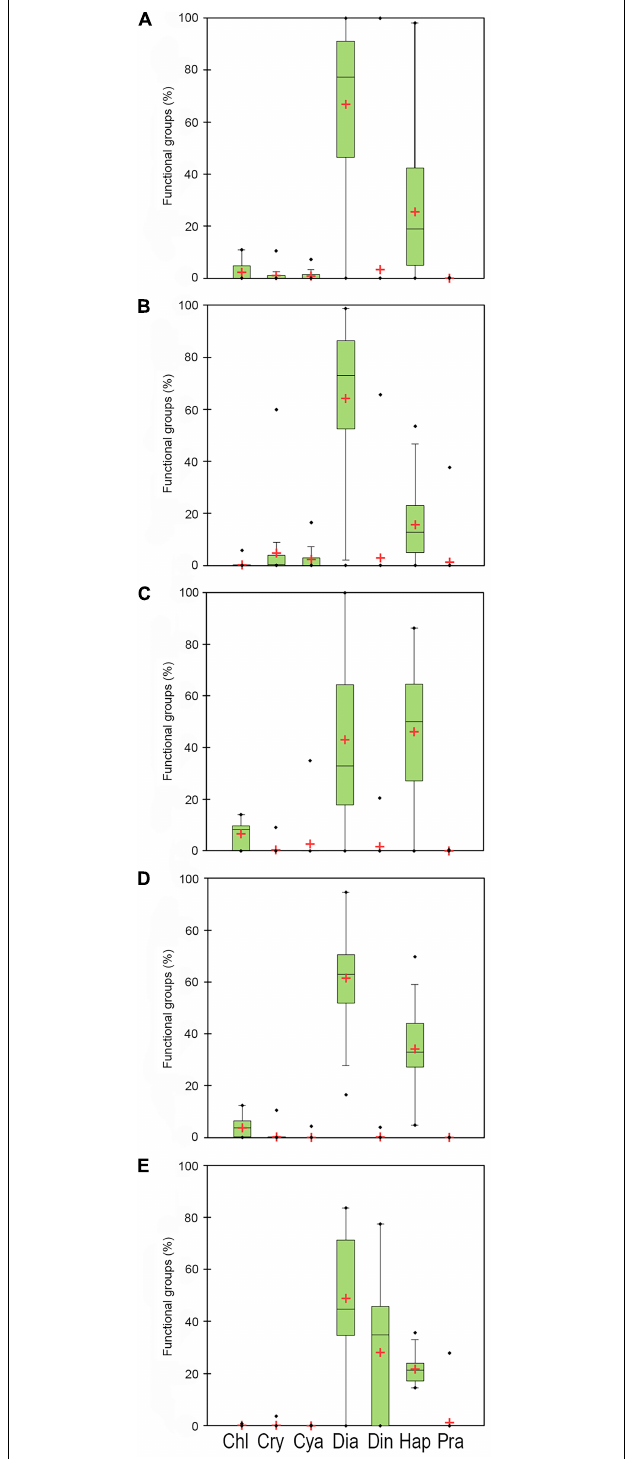
FIGURE 6 | Percentage contribution of the main functional groups to total biomass; i.e., chlorophytes (Chl), cryophytes (Cry), cyanophytes (Cya), diatoms (Dia), dinoflagellates (Din), haptophytes (Hap), prasinophytes (Pra), in Area 1 (A) , 2 (B) , 3a (C) , 3b (D) , and 4 (E) . The black line is the median and the red cross is the